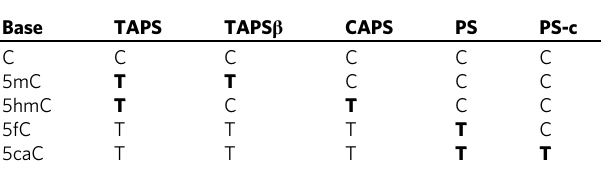
T T T T T C-to-T transitions marked in bold were recognized as modi fi ed